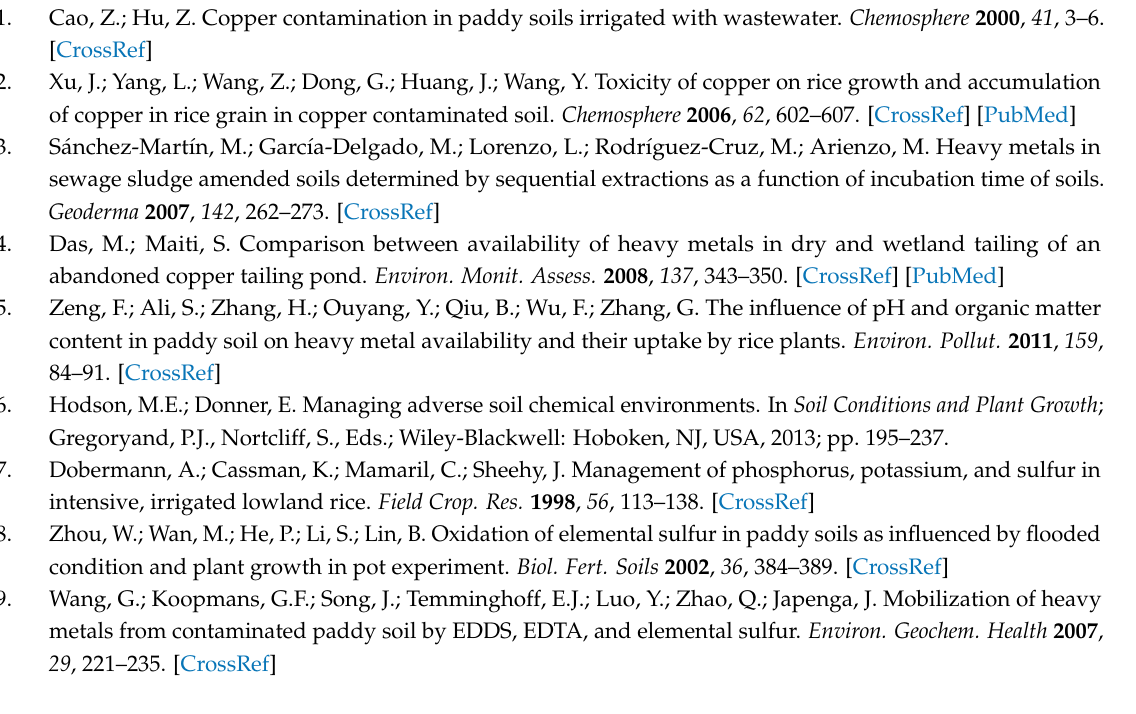
Figure S1: Photos of rice seedlings taken at tillering stage grown in a Cu-contaminated paddy soil and treated with increasing doses of sulfur or silicon amendments. S0, S1, and S2 represent sulfur applied at rates of 0, 0.013, and 0.026 g S kg − 1 soil, respectively, by using finely ground elemental S0; while Si0, Si1, and Si2 represent silicon applied at rates of 0, 0.05, and 0.1 g Si kg − 1 soil, respectively, by using Na 2 SiO 3 · 9H 2 O. Note the reddish rice root due to the formation of iron plaque on